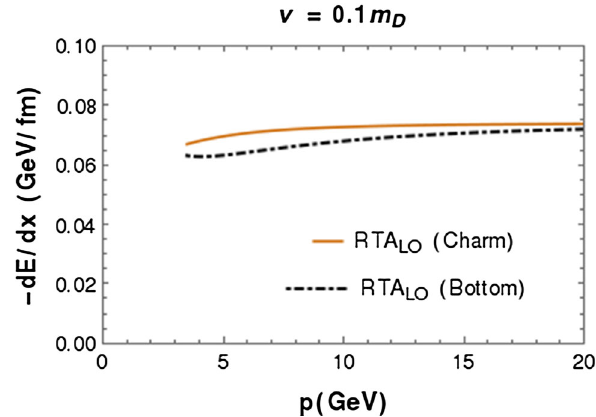
Fig. 4 Energy loss of charm and bottom quark using the RTA kernel at ν = 0 . 1 m D and T = 2 T c